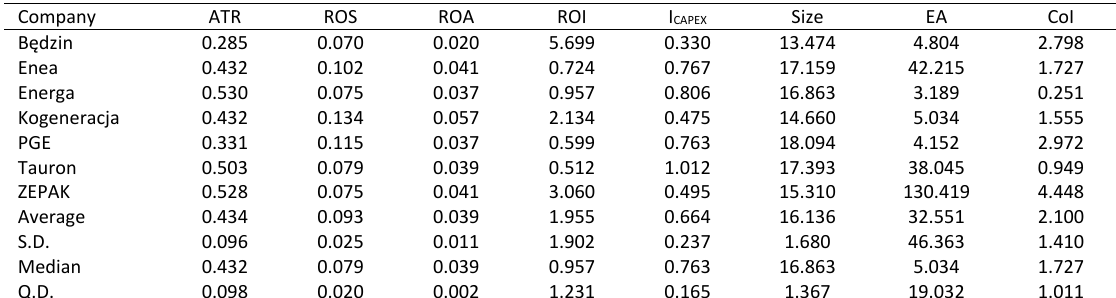
Table 6: Financial and environmental ratios for Polish energy groups in 2017 Company ATR